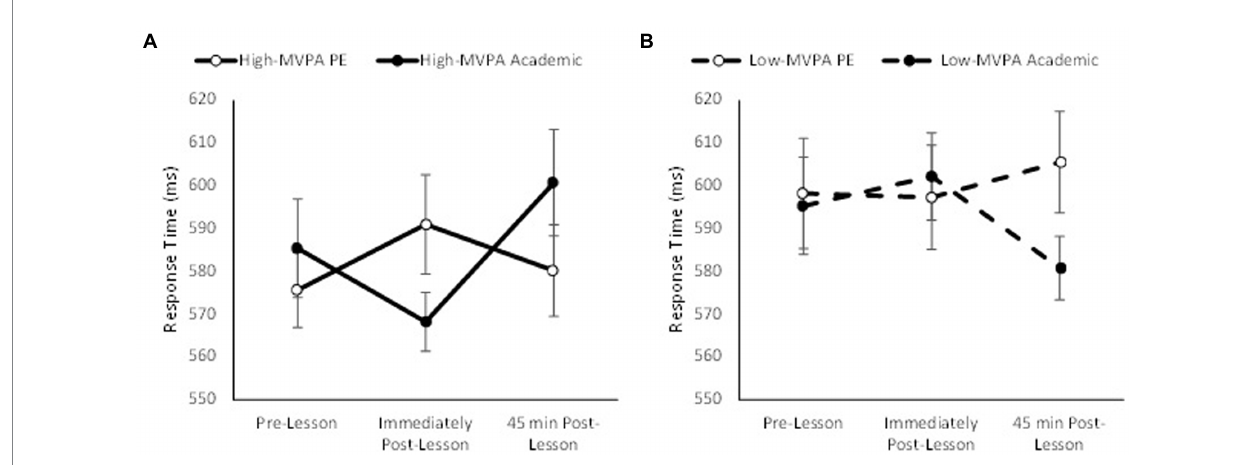
FIGURE 7 Response times across the morning on the simple level of the visual search on the PE and academic lesson trials for the high MVPA (trial * time, p < 0.001; A ) and low MVPA (trial * time, p = 0.026; B ) groups (trial * time * MVPA, p < 0.001).